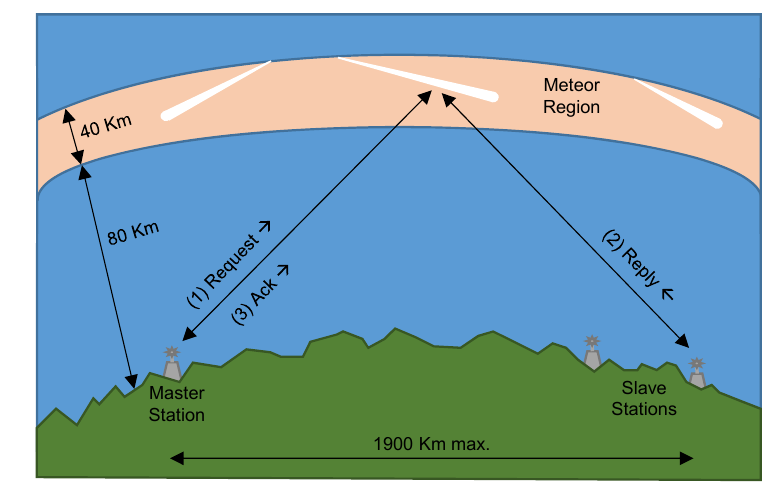
Figure 7. Example of Meteor Burst